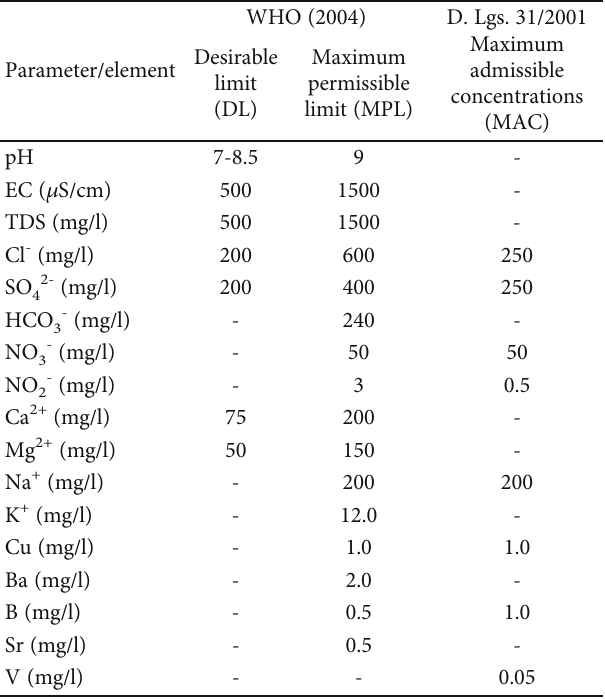
Table 4: Drinking water quality standard of WHO [60] and Italian legislation (D. Lgs. 31/2001,